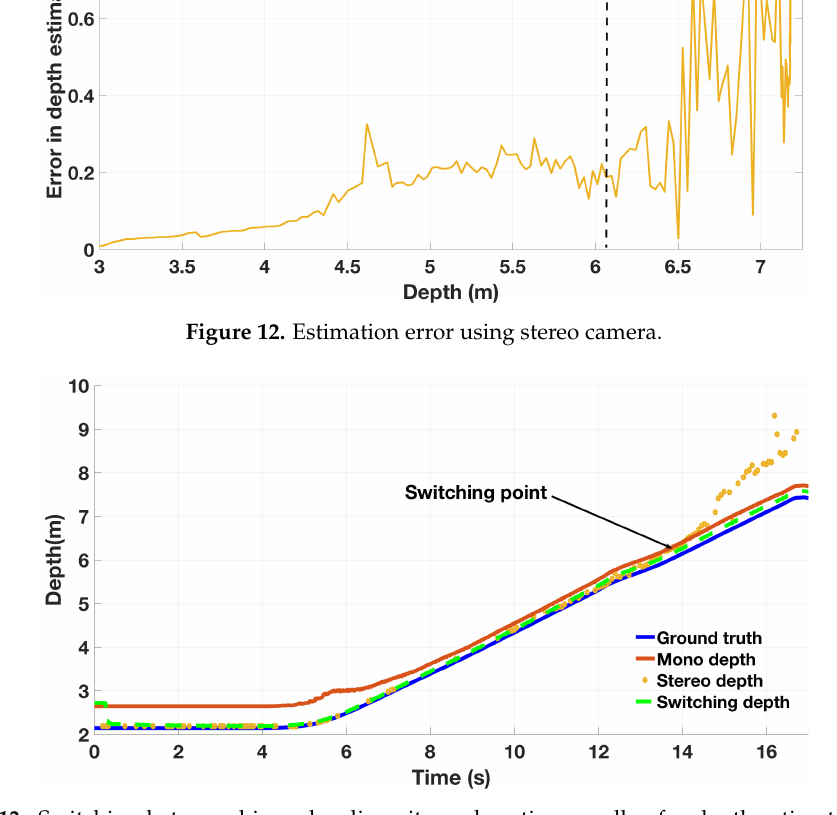
Figure 13. Switching between binocular disparity and motion parallax for depth estimation. The camera resolution is set to